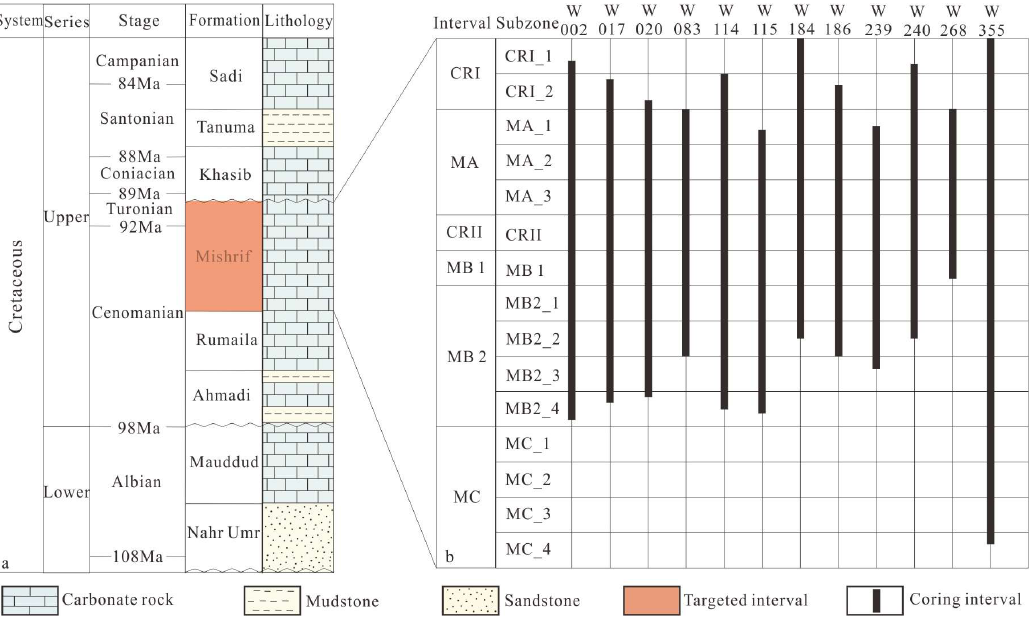
Figure 3. Overview of top structure, interval, and cored well of Mishrif Formation in X Oilfield. ( a ) Strata of study area; ( b ) strata and coring interval in the Mishrif Formation.